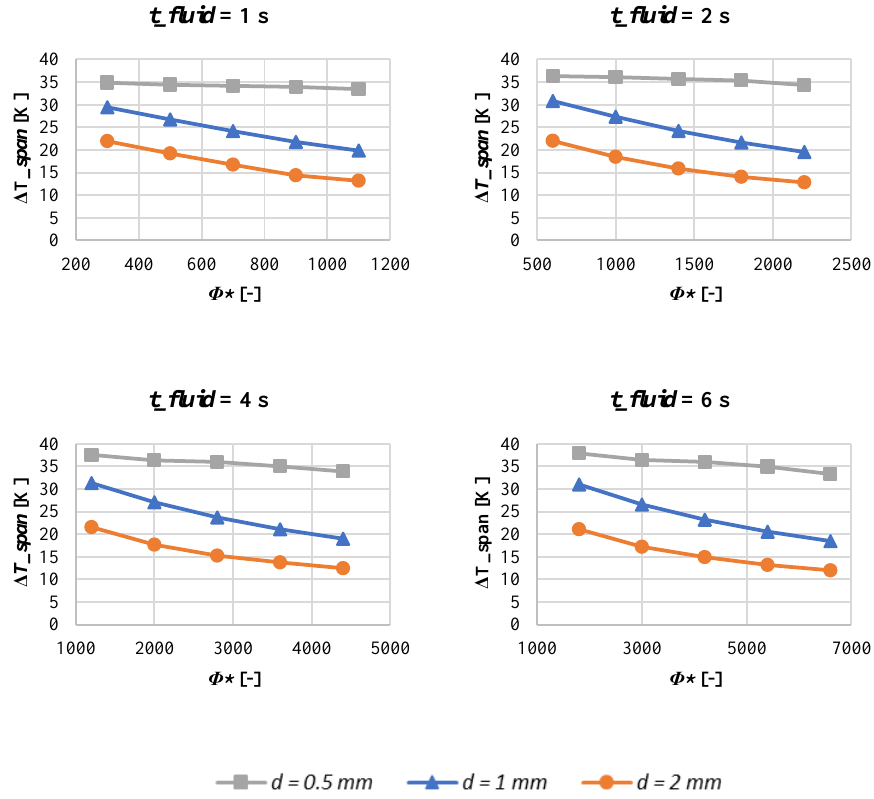
Figure 6. Temperature span as a function of the utilization factor, parametrized for the distance between two wires. Each subplot refers to a tested t CHT dataset.